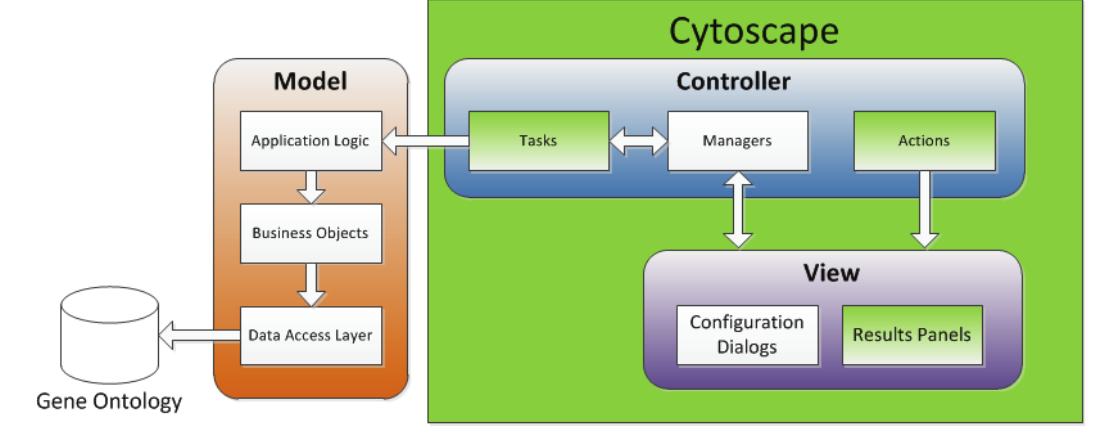
Figure 1. Diagram of GFD-Net architecture. The areas in green are directly extending or using the Cytoscape